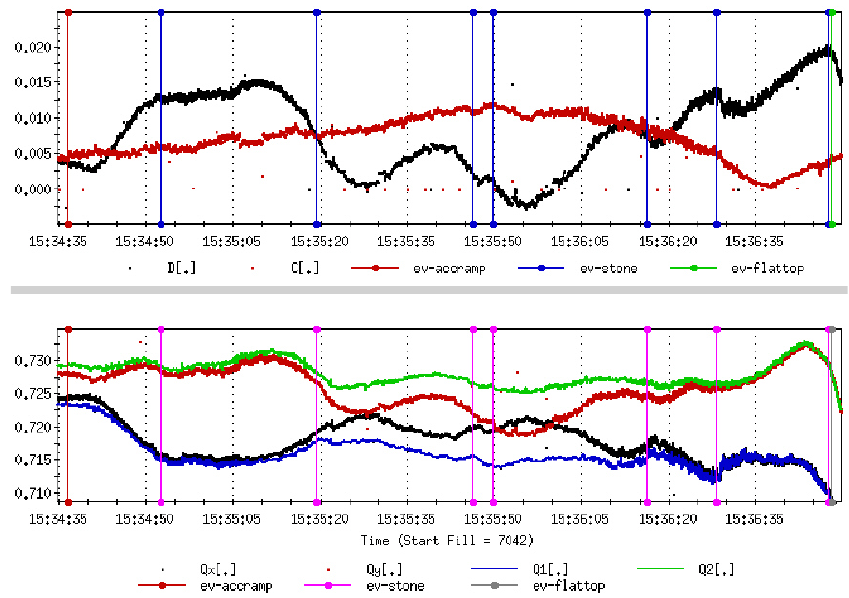
FIG. 9. (Color) Coupling parameters, measured tunes, and set tunes during a ramp.